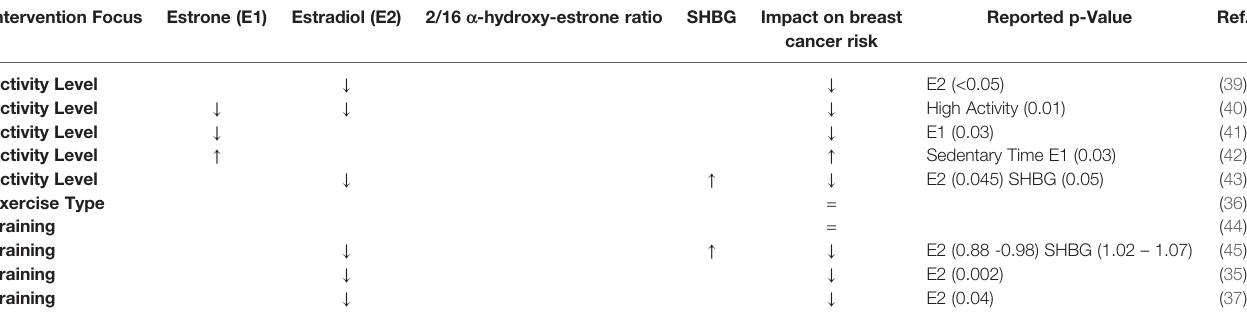
TABLE 4 | Breast cancer risk and estrogen level changes assessed in exercise intervention studies.